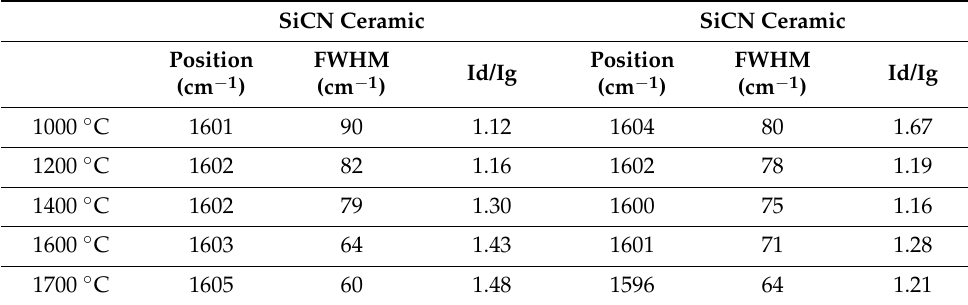
Table 3. Position, FWHM and Id/Ig for SiCN and SiC 3D